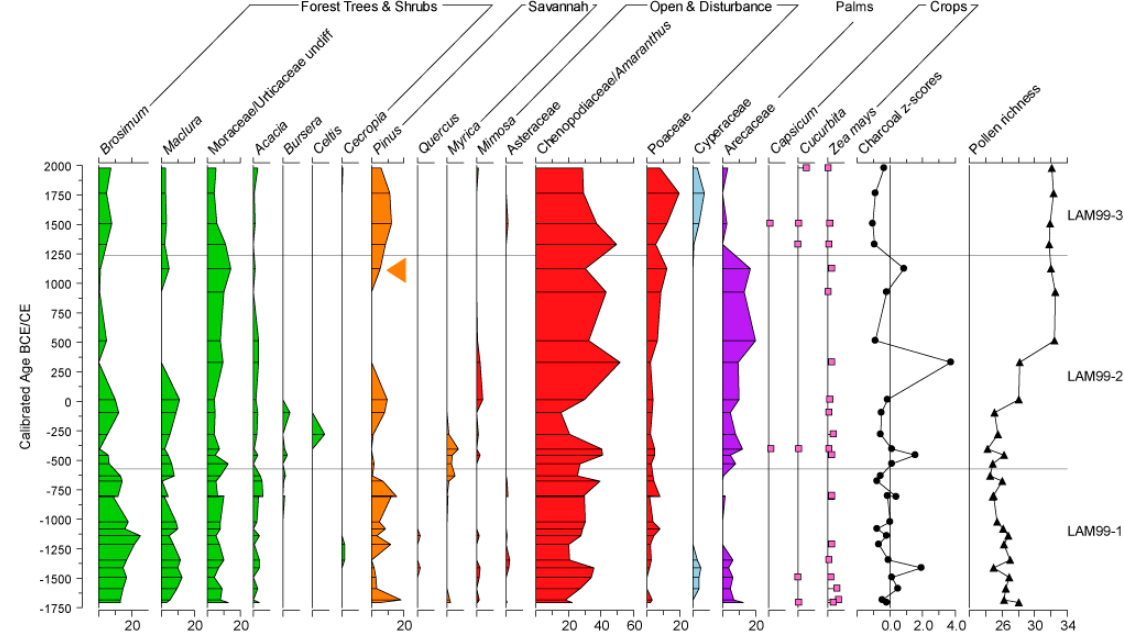
Figure 3. Pollen percent abundance data, rarefied pollen richness data, and transformed charcoal data (z-scores) from Lamanai-99 plotted against the reanalysed age-model. The arrow marks the horizon (rise in pine pollen) used to correlate the chronologies of the two records.